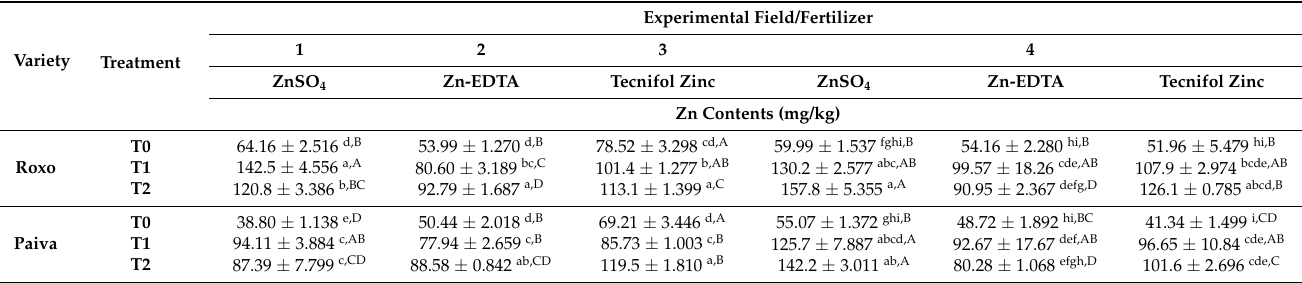
Table 2. Average Zn contents ± SE ( n = 12) of whole wheat flour of Triticum aestivum L., varieties Roxo and Paiva, from experimental fields 1–4, after fertilization ZnSO 4 , Zn-EDTA and Tecnifol Zinc.